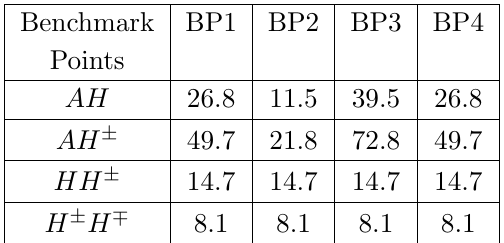
Table 6 . Tree-level cross-section for the benchmark points obtained by CalcHEP [43] in the units of fb at the LHC with center of mass energy of 14 TeV, scale, and CTEQ6L [44] as